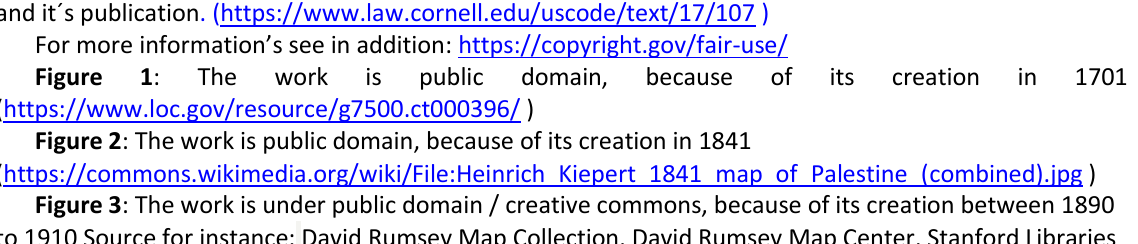
Figure 2 : The work is public domain, because of its creation in 1841 Figure 3 : The work is under public domain / creative commons, because of its creation between 1890 to 1910 Source for instance: David Rumsey Map Collection, David Rumsey Map Center, Stanford Libraries (https://www.davidrumsey.com/about/copyright-and-permissions ) Figures 4 and 5 , are under Copyright and Licence of Google/Alphabeth Inc. and its Permissions. Figure 6 : The work is under public domain because of its creation in